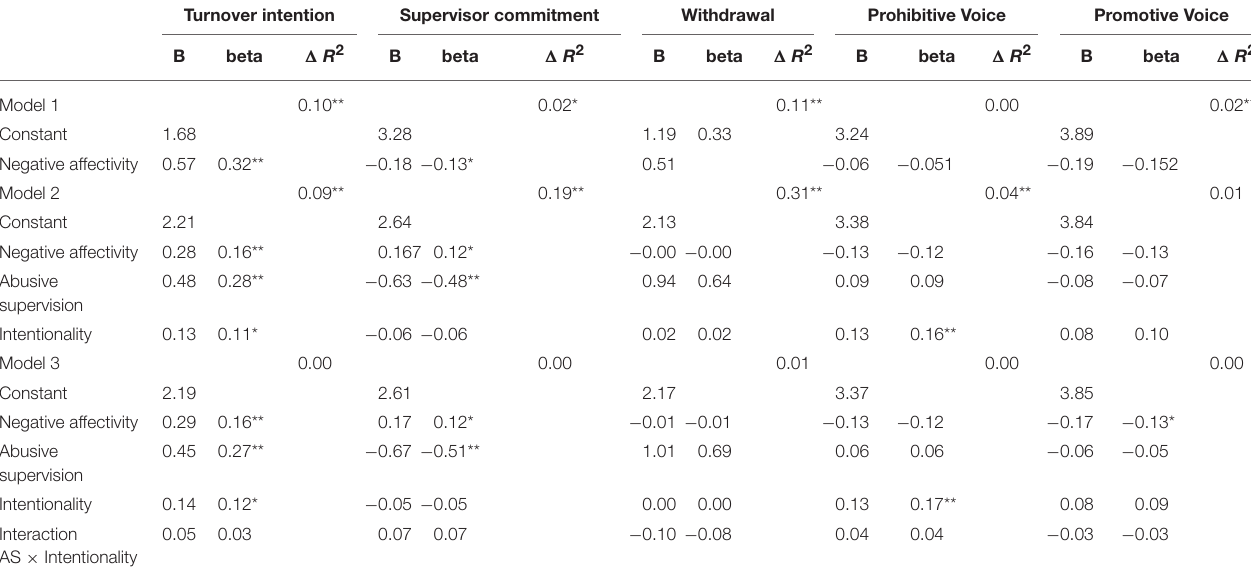
TABLE 7 | Moderated regression analyses attribution to intentionality and reactions (Study 3). Turnover